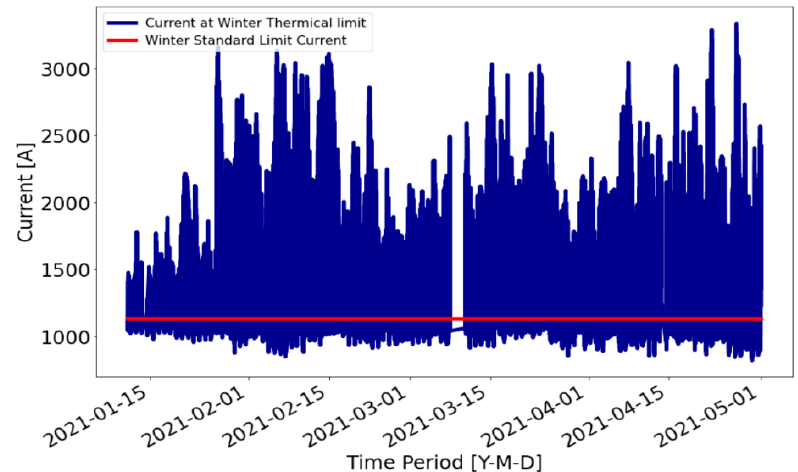
Figure 12 . Current trend for winter period of a generic HV Line.